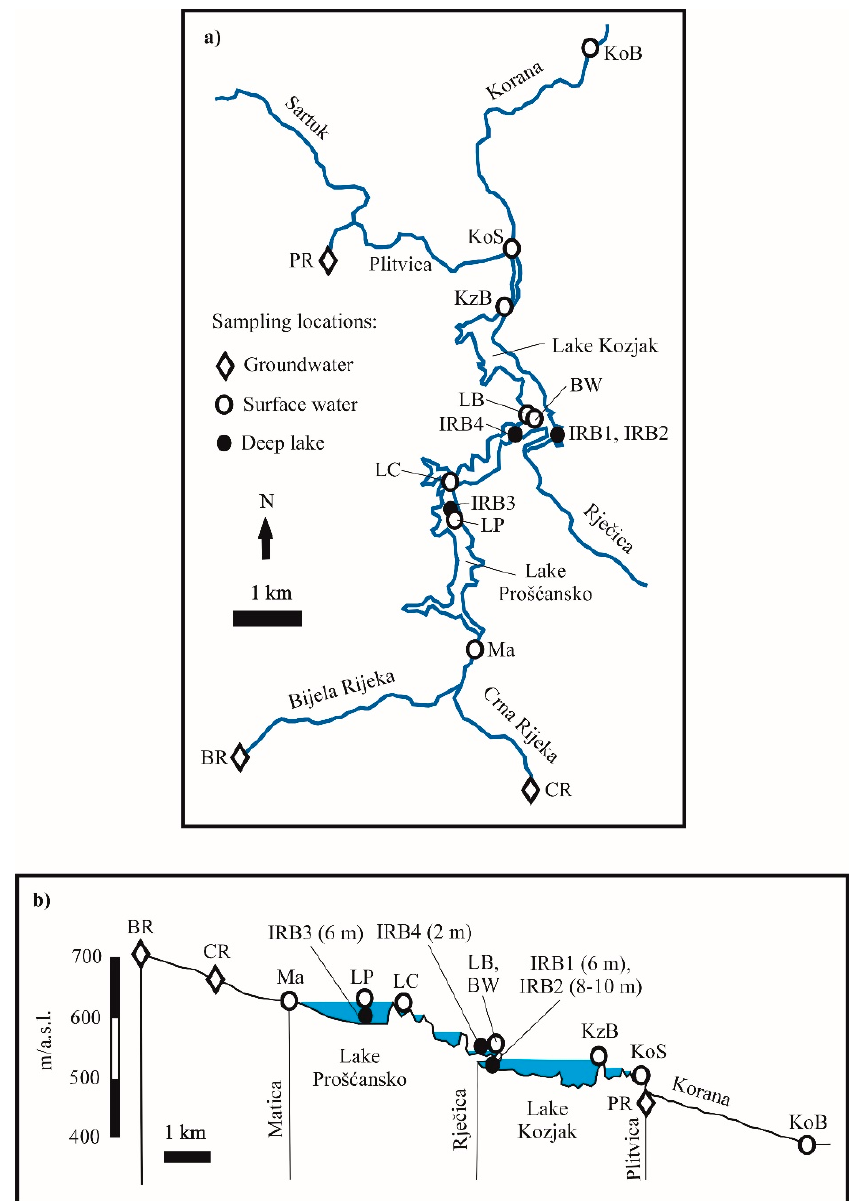
Figure 2. Sampling locations: ( a ) along the water course (top view); ( b ) along the profile. For an explanation of the location codes, see Table 1. Table 1. List of sampling locations, their codes, and the types of water body samples.